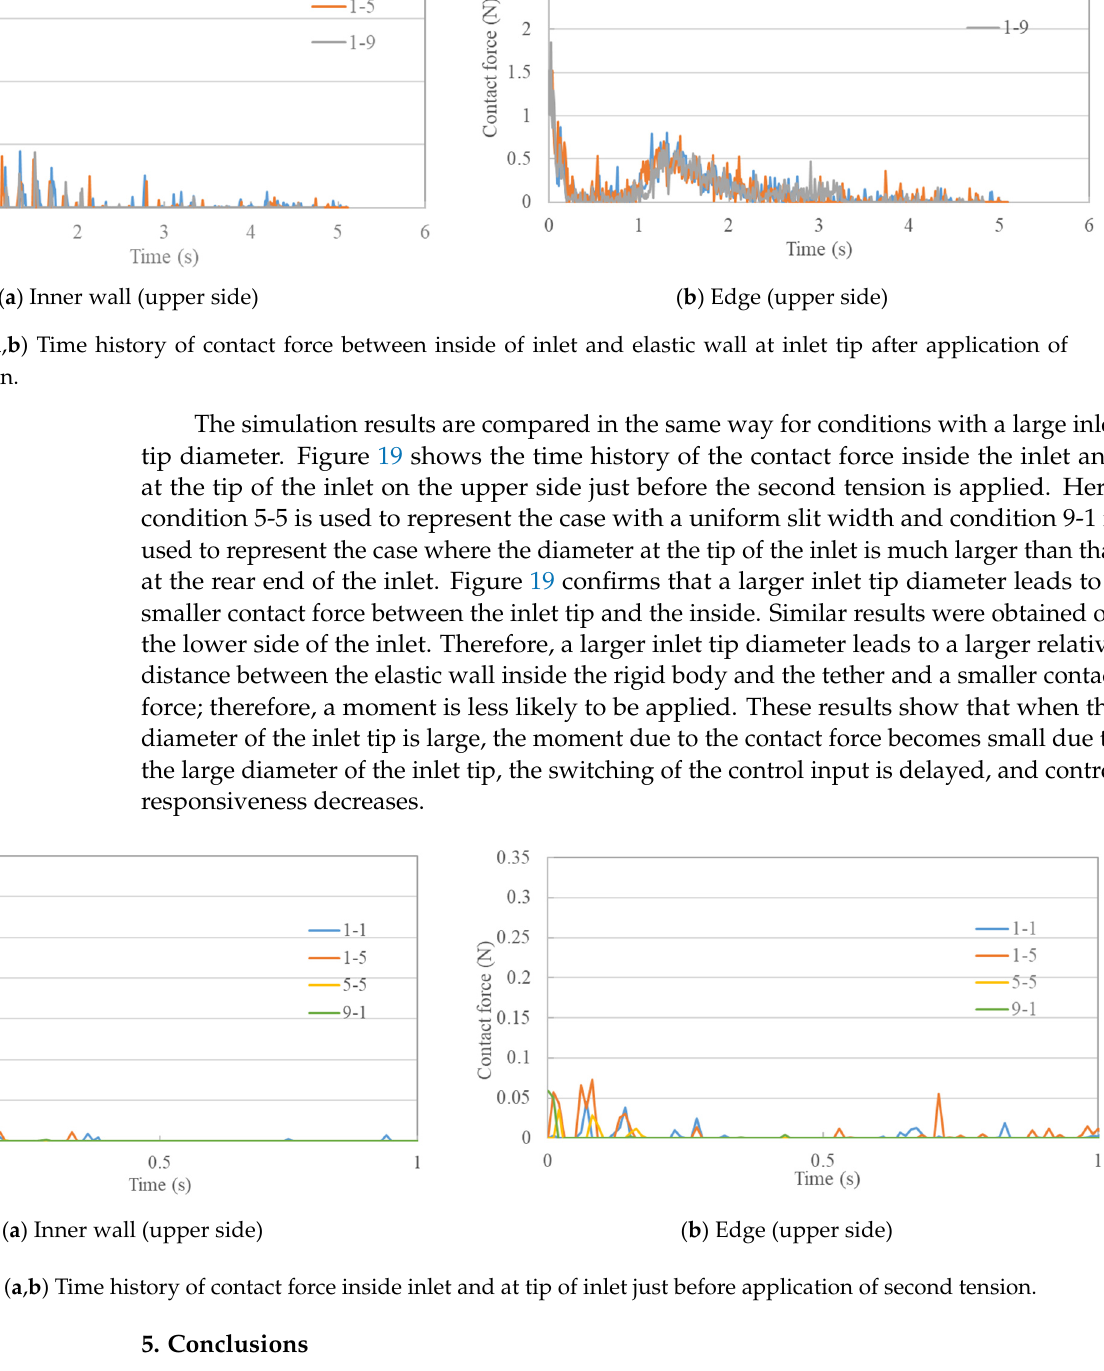
13 Figure 16. Time history of moment due to contact force. Figure 17. Contact force distribution. Figure 18 shows the time history of the contact force between the inside of the inlet